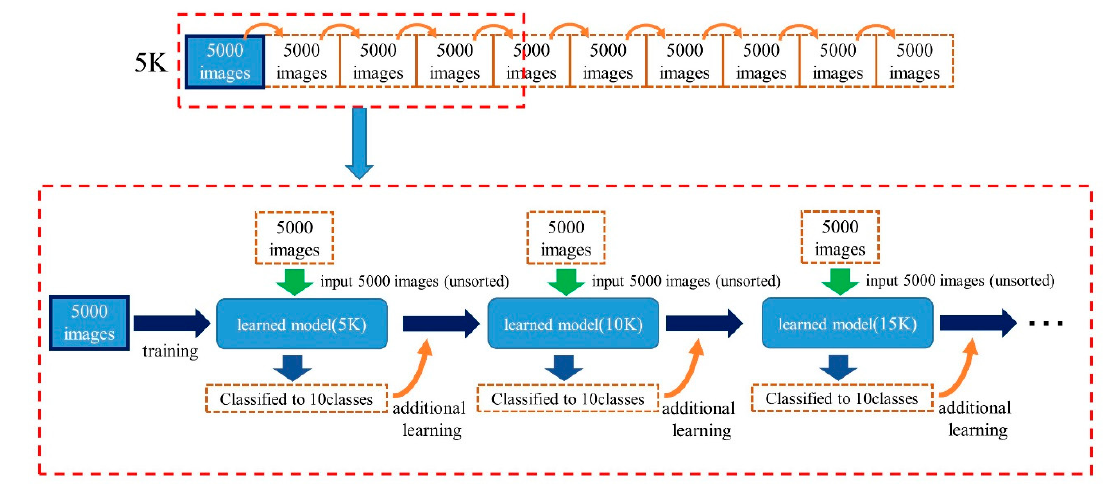
Figure 4. Details of the additional learning process for automatic training (Example case using 5 K datasets) .